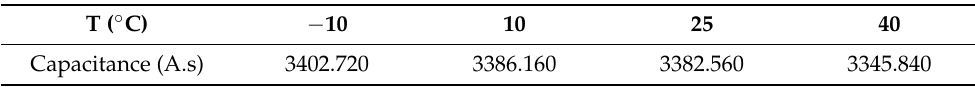
Table 1. The rated ultracapacitor capacities at different temperatures.